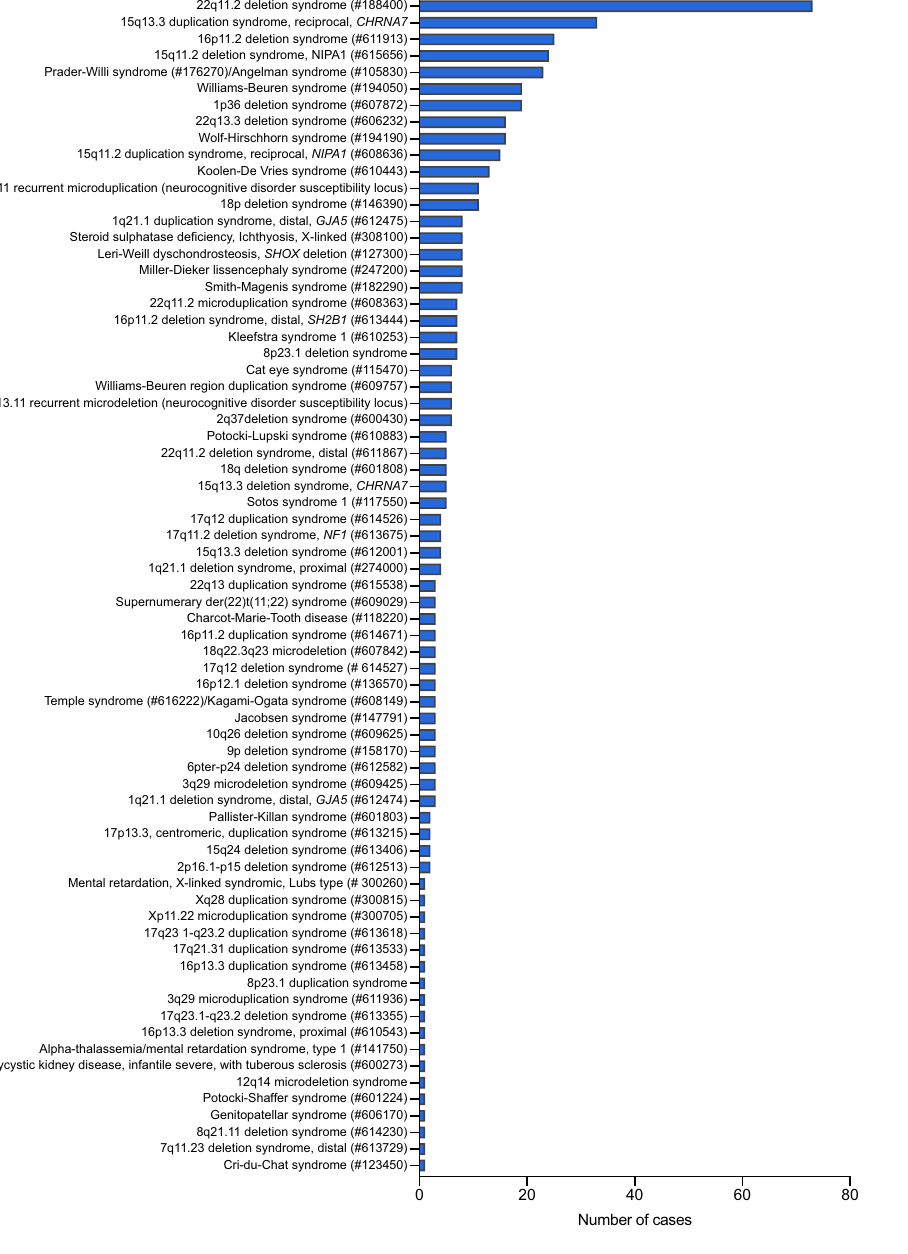
Figure 4. Distribution of microduplication and microdeletion syndromes. The histogram shows the frequency of microduplication and microdeletion syndromes identified in a total of 477 patients with neurodevelopmental disorders. Results are displayed in the descending order of